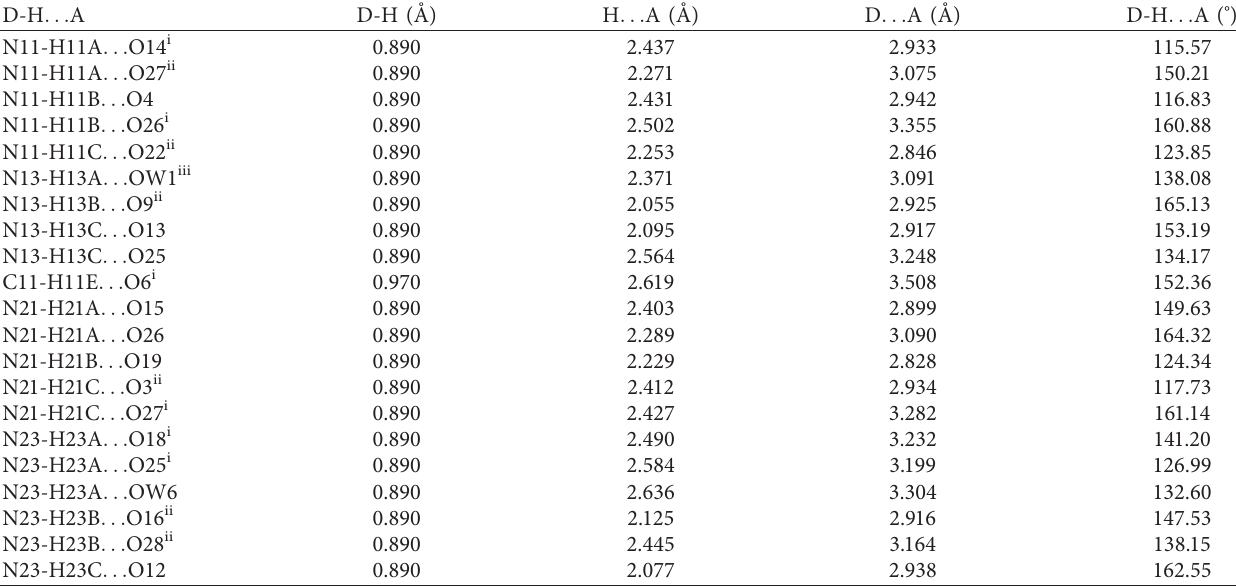
· 4.21H 7 N 3 H 20 ) 2 V 10 O 28 2 O structure along the [010]